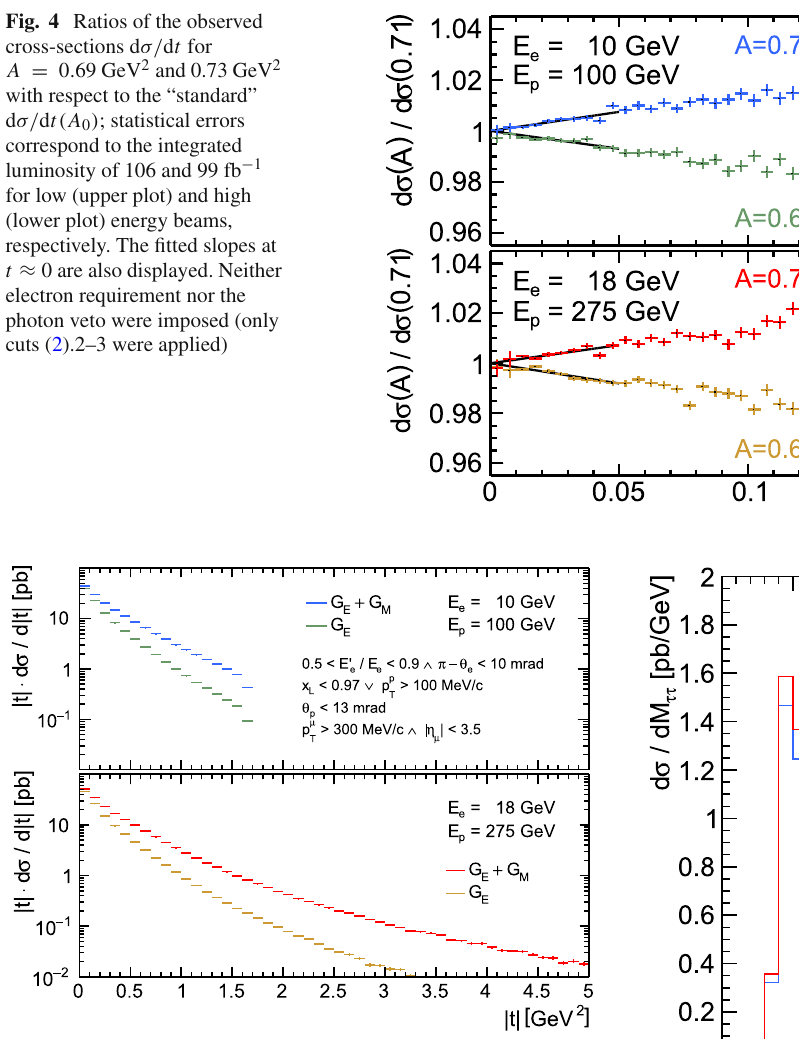
Fig. 5 Differential cross-sections, | t |· d σ/ d | t | , for accepted the events withoutthephotonveto;forlow(upper)andhigh(lower)energybeams, where the statistical errors correspond to the integrated luminosity of about 300 fb − 1 . The plots compare distributions obtained using the full